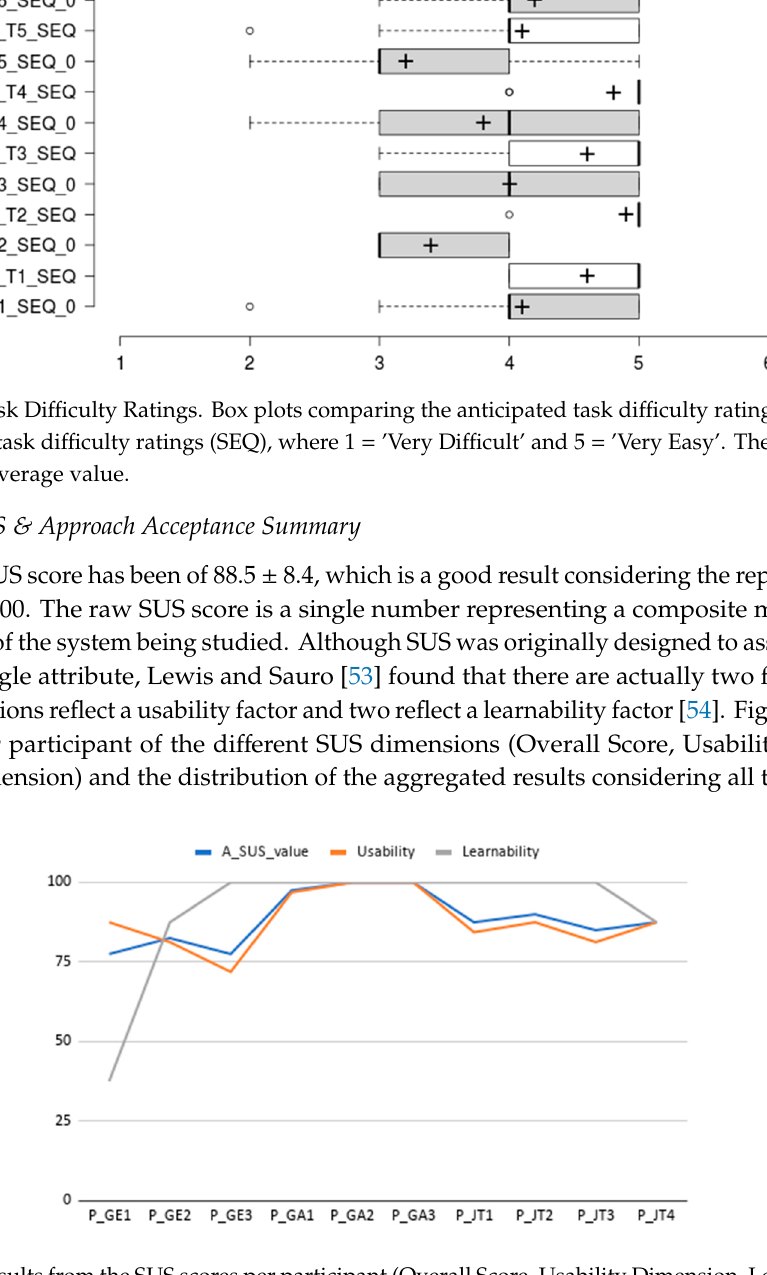
Figure 17. Results from the SUS scores per participant (Overall Score, Usability Dimension, Learnability Dimension). Line chart shows the score achieved in each dimension for each participant and dimension. Value range is from 0 (minimum score) to 100 (maximum score).